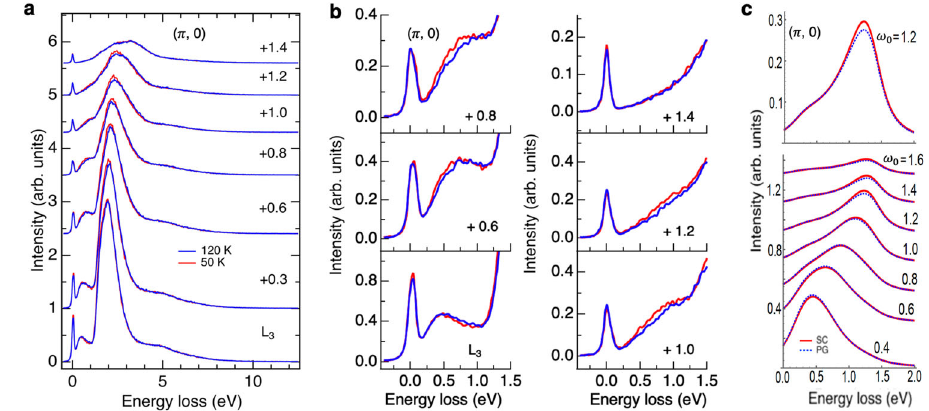
(blue broken curves) for Q ∥ =( π , 0) by using equations (1) and (4) as is detailed in Methods and in Supplementary information. The lowerpanel shows the spectraof selected incident energies ω 0 and the upper panel is the zoom-in spectrum for ω 0 =1.2eV to highlight the enhancement in the superconducting state clearly. The incident energy ω 0 measured from E F isgiven in units of eV. The core-hole lifetime width Γ and the broadening factor η wereset to 0.3eV and 0.1eV,respectively. For clarity,spectrain a areplotted with averticaloffset, of whichare identicalforeach incident photon energy. Spectra in c are also presented with a vertical offset in a scheme similar to that of a